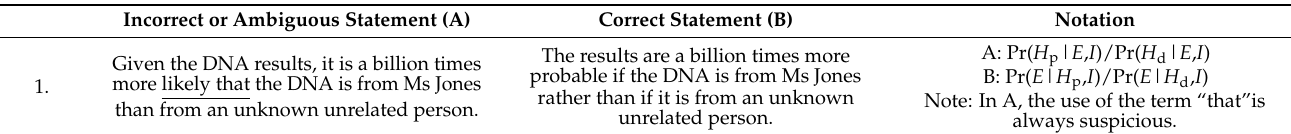
Table 2. Statements with transposed conditionals and their associated correct